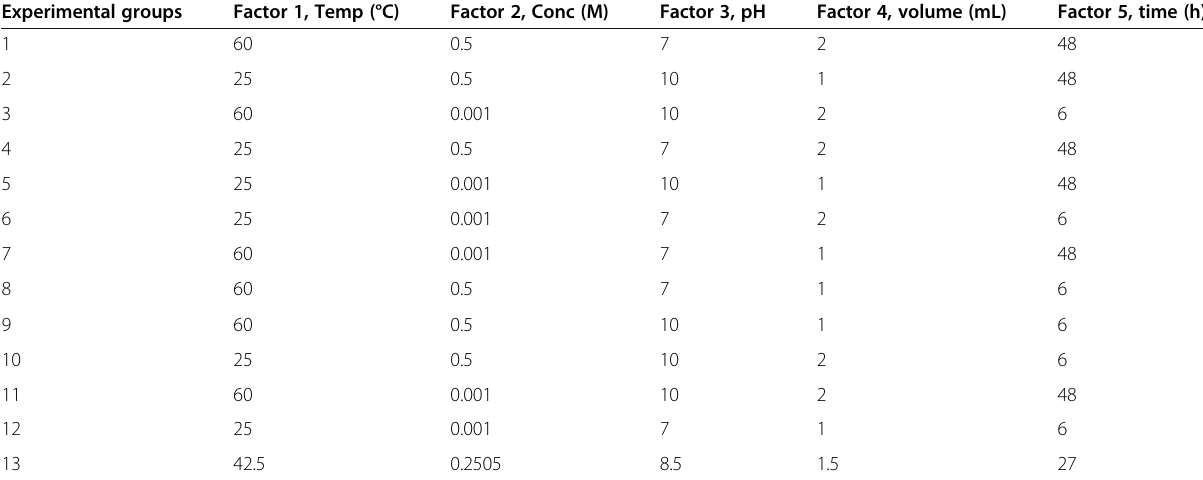
Table 1 Plackett-Burman experimental design matrix for the screening of various factors for total demineralization of skeletal remains. Thirteen experimental runs were generated using the Design-Expert software for five different factors Experimental groups